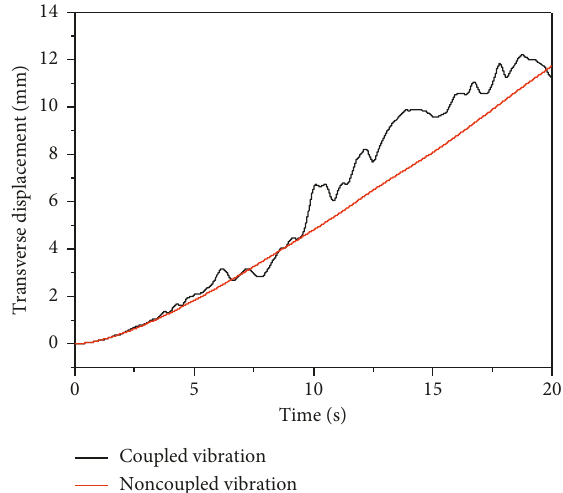
Figure 9: Effect of coupling on transverse vibration.